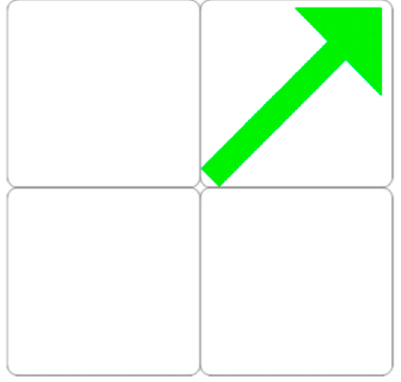
Figure 6. Initial screen.